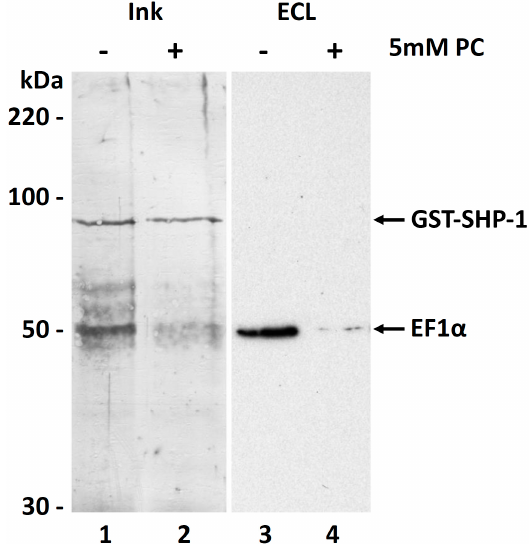
Figure 7. Interaction of L. infantum EF1 α with human SHP-1. Leishmania EF1 α co-purifies with human GST-SHP-1 as detected in a Western blot by the eEF1 α -specific antibody (lane 3 ). This interaction is almost completely abolished in presence of 5 mM phosphorylcholine (lane 4 ). Lanes 1 and 2 show an Ink-staining of the proteins co-eluting with the GST-tagged phosphatase SHP-1 directly on the PVDF membrane. Whereas the SHP-1 (~90 kDa) is visible in both lanes at similar amounts, a band corresponding to EF1 α (~50 kDa) is much stronger in lane 1 than in lane 2, were PC interrupts their interaction.